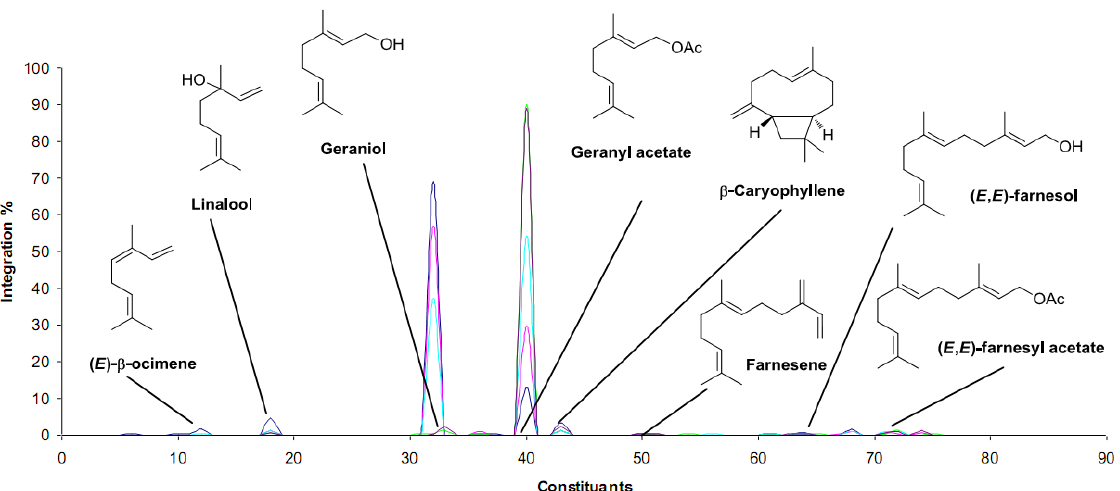
CRL-catalysed acetylation based on GC-FID analysis (navy: original sample of palmarosa; pink: 20% acetylation; light blue: 40% acetylation; green: 80% acetylation; purple: 100% acetylation). See ref. 35 for analytical conditions and